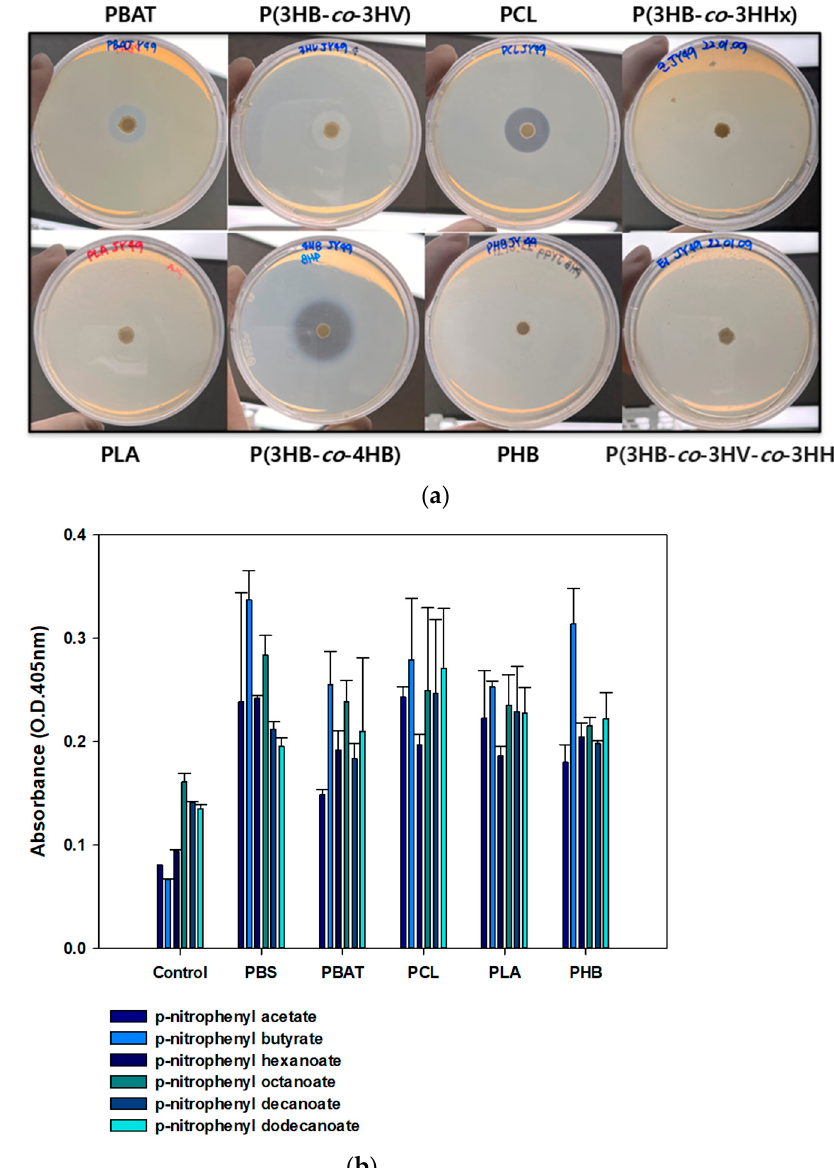
Figure 6. Degradation ability of JY49 on other bioplastics. ( a ) Formation of clear zone was tested on plates containing other plastics at 30 °C for 7 days. ( b ) Esterase assay was conducted with various p-nitrophenyl esters, and absorbance was measured at 405 nm.